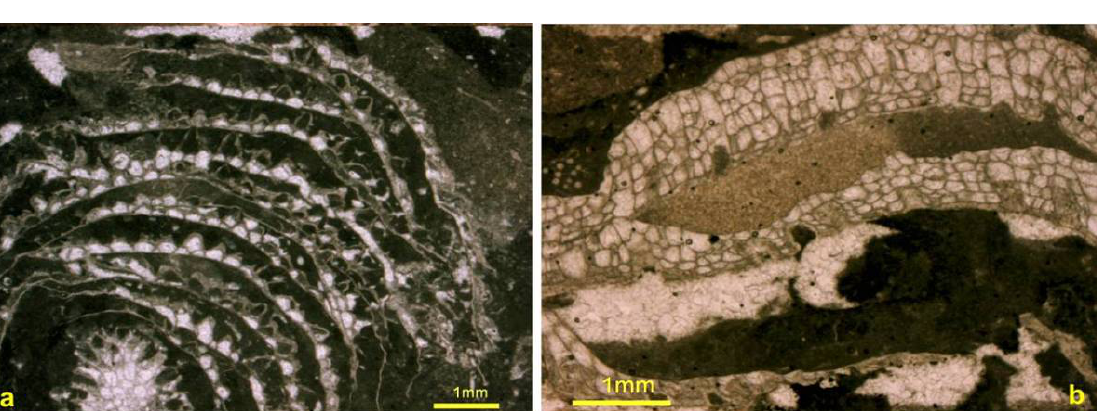
Figure 10. Reef initiators. ( a ) encrusting bryozoan common in basal reef layers (GSC125462, locality A1198); ( b ) multiple platy bryozoans in basal reef layers roofing over cavities (GSC129915, locality A1489); ( c ) domal bryozoan from reef core (GSC128040, locality A1293); ( d ) basal reef layers with clast-forming recrystallized chlorophyte Paleoporella (GSC128659, locality A1489); ( e ) multiple layers of very thin, roofed and stacked from base up, platy bryozoan, encrusting corals such as Placocoenites (middle) and at top, Subalveolites (GSC128659, locality A1489); ( f ) Trypanites borings in reef framework (GSC128660, locality A1198); ( g ) encrusting tabulate coral Subalveolites and reef sediment, cavities (GSC128660, locality A1198); ( h ) basal reef hash of recrystallised Paleoporella (GSC128667, locality